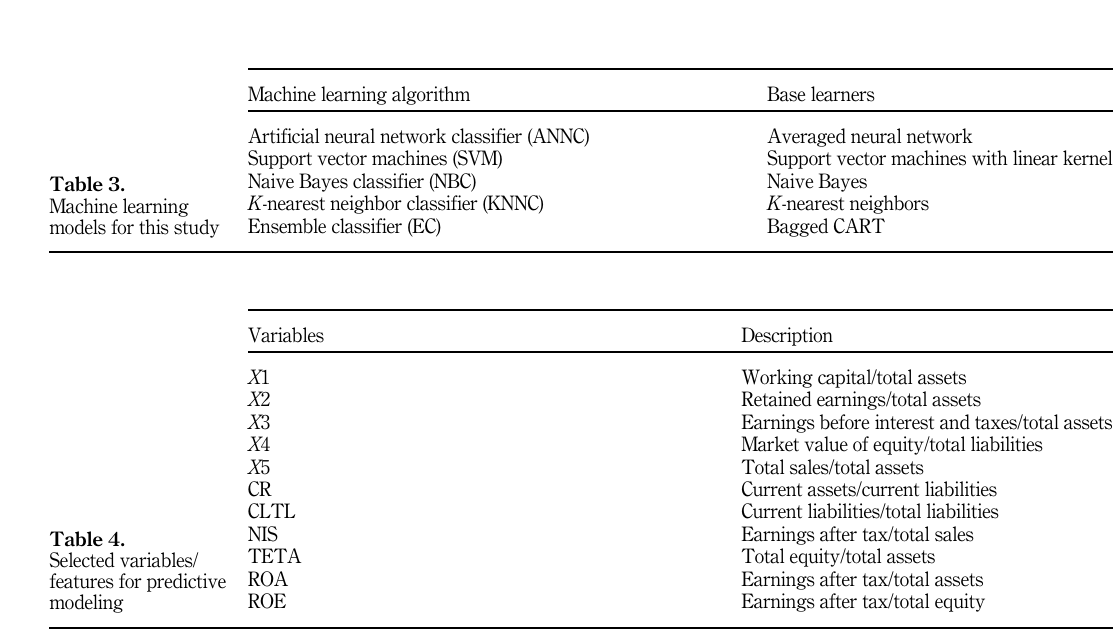
Table 4. Selected variables/ features for predictive modeling